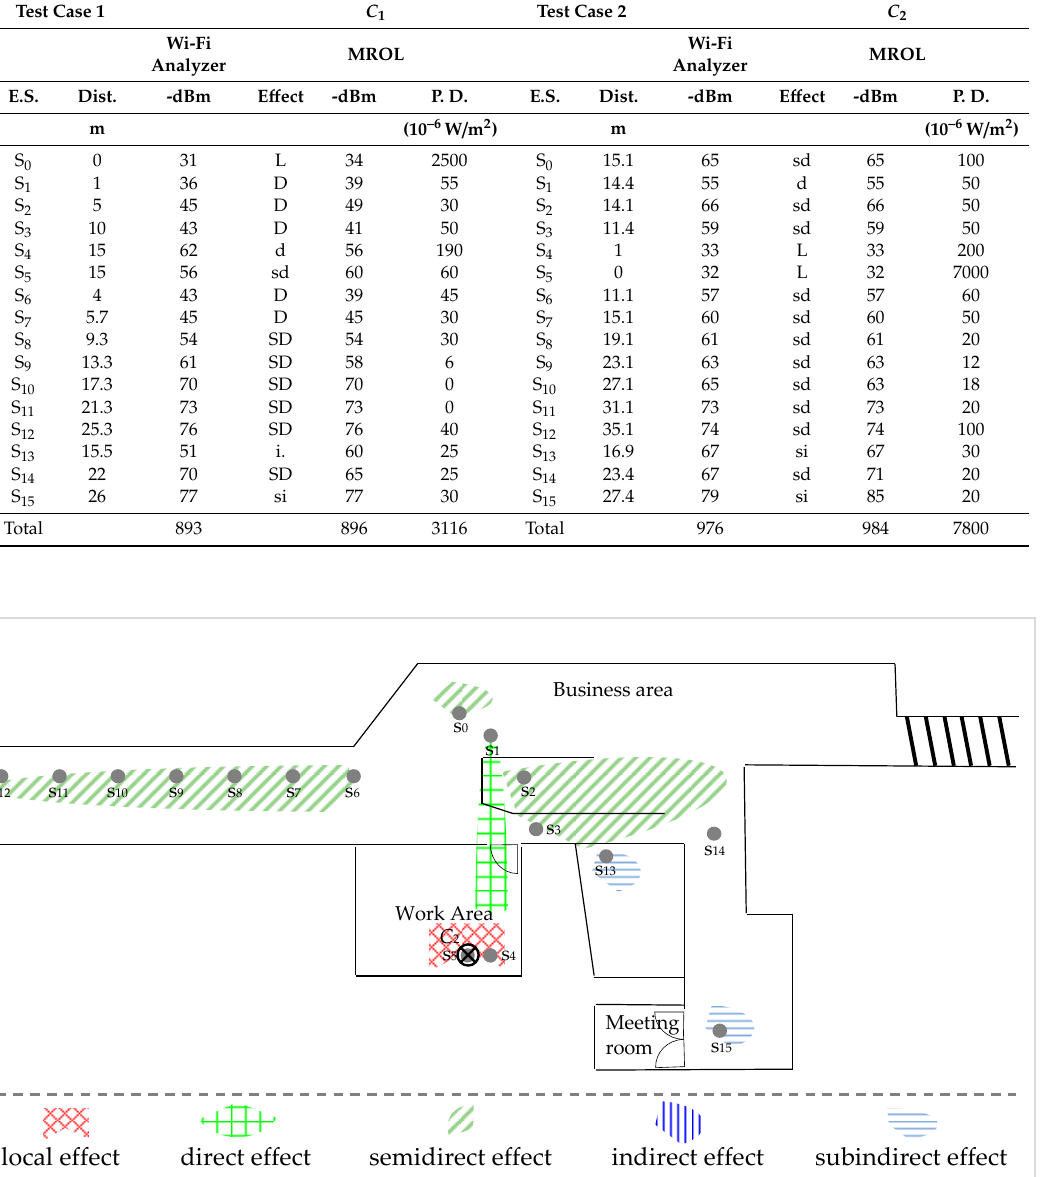
Figure 13. Electromagnetic wave power density for C 2 to S 0 , S 1 , …, and S 15 . s 15 s 14 s 13 s 12